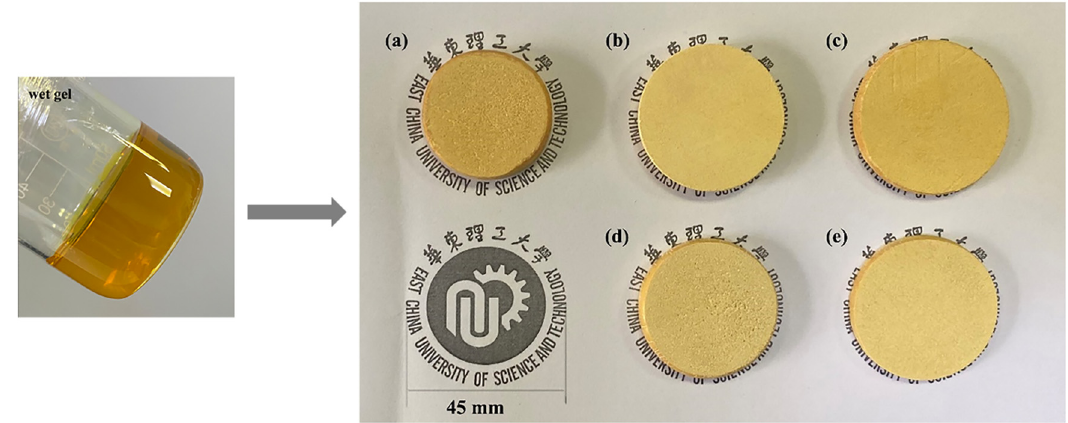
Figure 3: The photos of a BTPB ( /TMOS ) wet gel and some aerogels with di ff erent shrinkage ( a ) BTPB - 20 - 0, ( b ) BTPB - 20 - 0.25, (